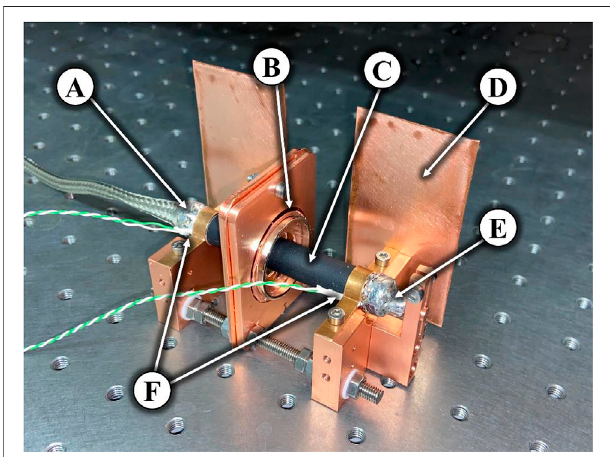
FIGURE 10 | Enhanced setup with three axially magnetised neodymium 30UH permanent magnet rings positioned coaxially to the current lead. (A) Coaxial wire connection; (B) Permanent magnet ring; (C) BSCCO Current Lead; (D) Copper fi ns; (E) Coaxial wire; (F) Thermocouple